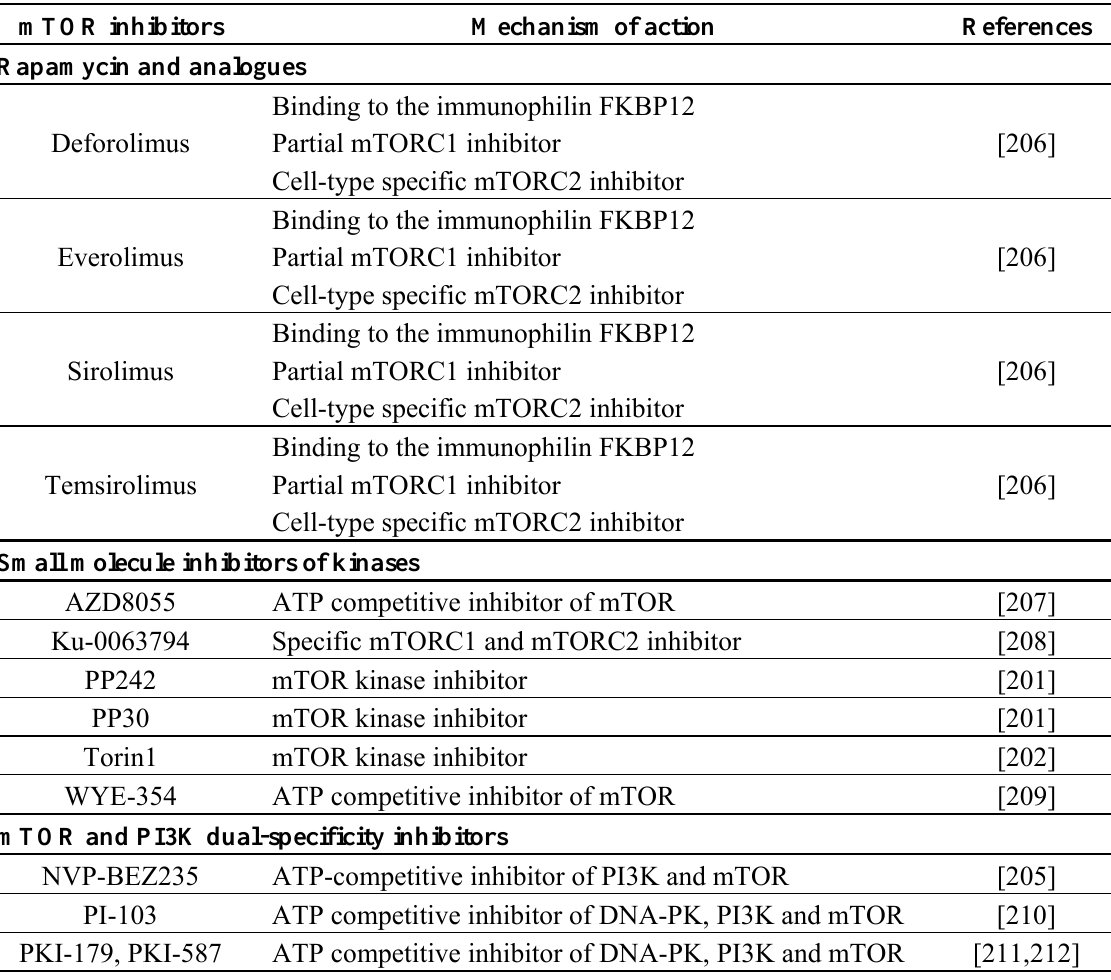
Table 2. mTOR inhibitors in clinical